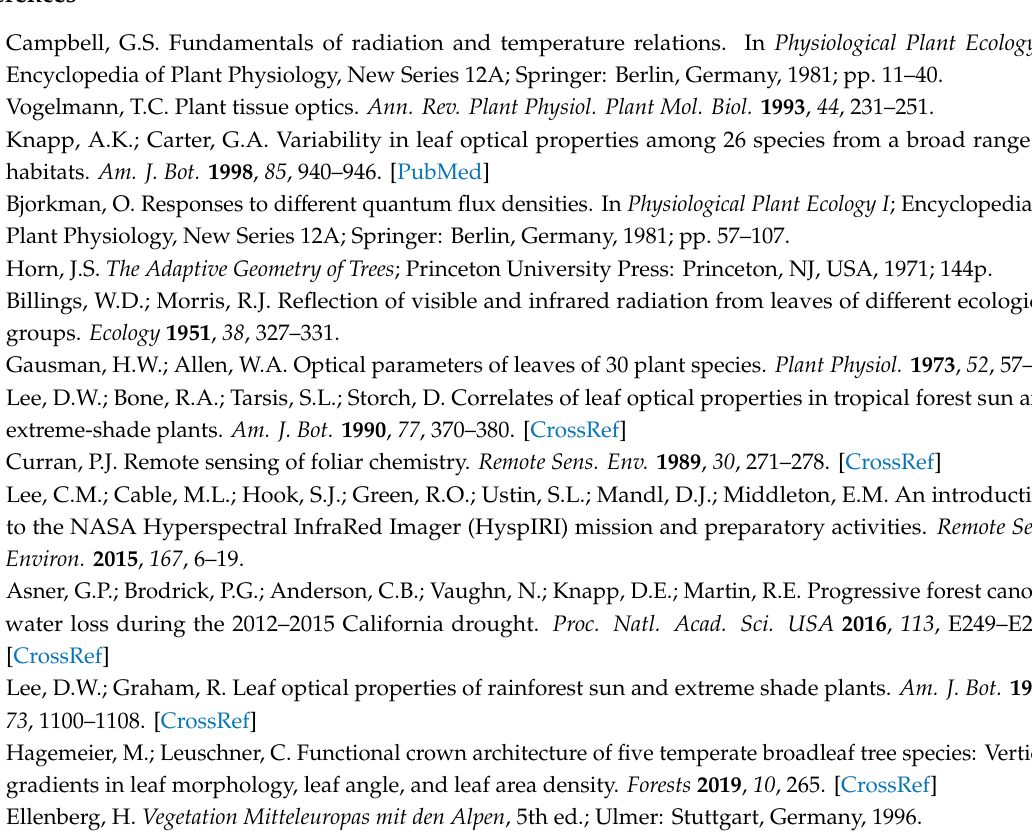
Figure S1: Plot for measuring PAR flux density on the forest floor. Figure S2: Absorptance of leaves of the five species in the sun, middle and shade crown integrated over the wavelength interval 350–720 nm (means with standard deviation of each 10 leaves). Figure S3: Transmittance of leaves of the five species in the sun, middle and shade crown integrated over the wavelength interval 350–720 nm (means with standard deviation of each 10 leaves). Figure S4: Relative PAR irradiance (in % of incident radiation) on the forest floor in each two stands with closed canopy of the five tree